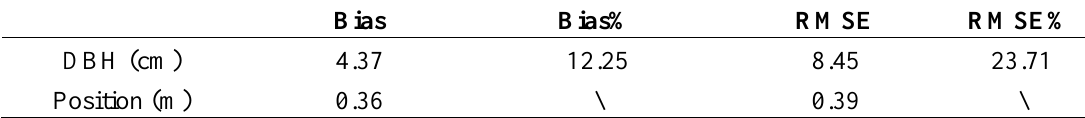
Table 7. The accuracy of the DBH and position estimates utilizing the merged PLS